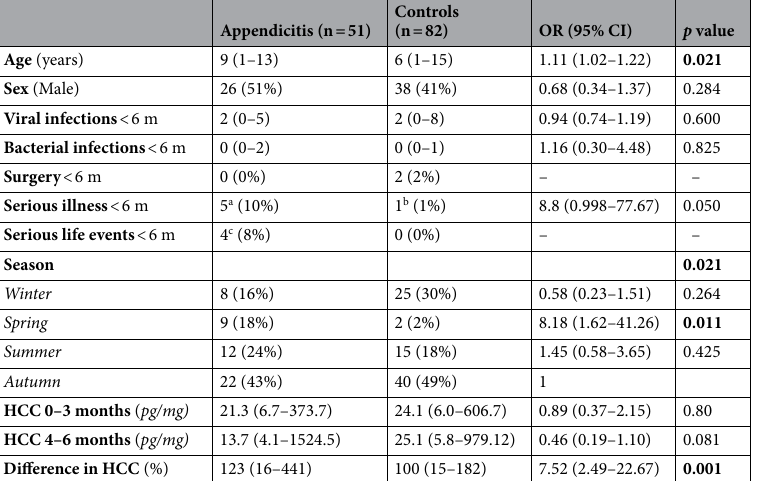
Table 3. Unadjusted independent variables of appendicitis in 51 children with appendicitis and 82 healthy controls. Values presented as median (min–max) or as absolute number (percentage of patients). M: male, F: female. n = 106 (66 controls, 40 cases) for HCC 4–6 months and difference in HCC. a) 2 fractures, 1 thyrotoxicosis, 1 severe autism, 1 severe ADHD; b) urinary tract disorder with long-term catheter; c) 1 with severely depressed father, 2 with domestic abuse, 1 with loss of close